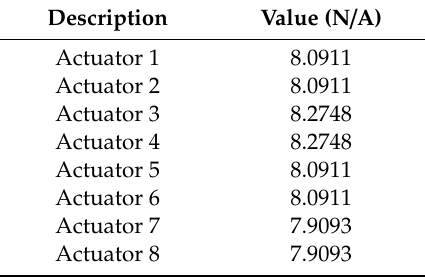
Table 2. Force constant of actuators.